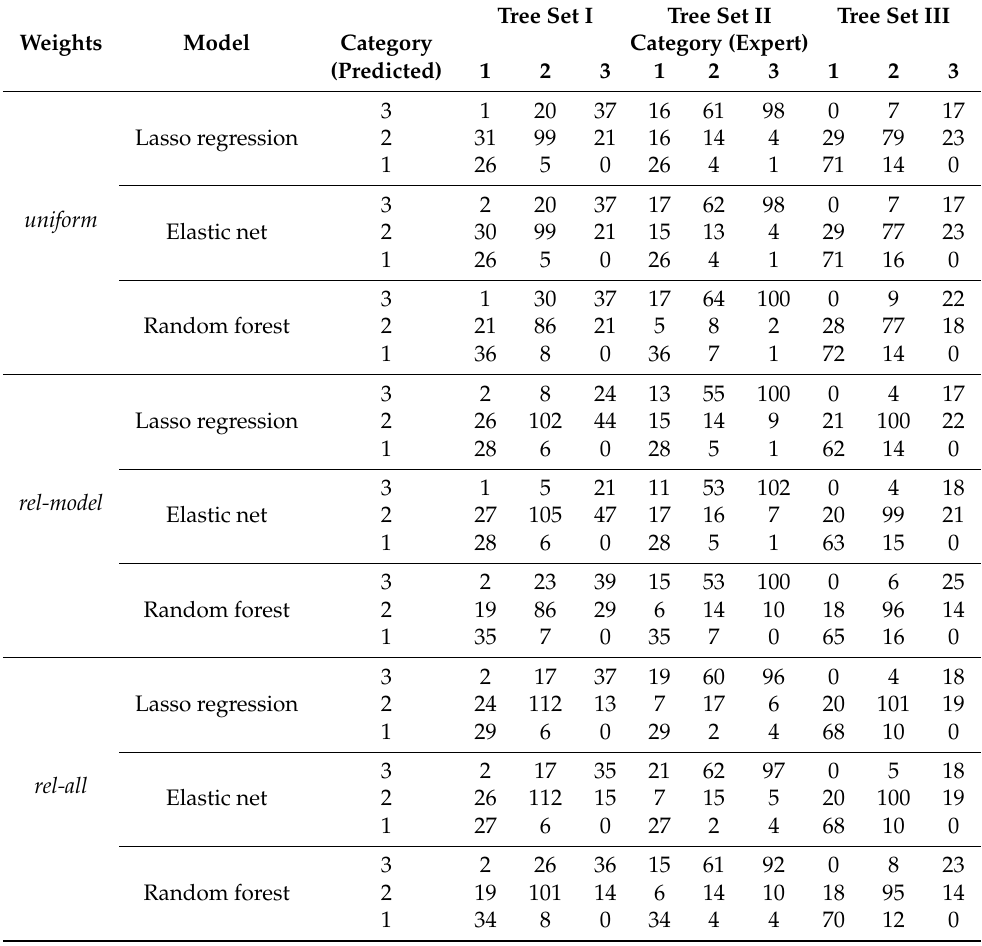
Table A1. Confusion matrices (absolute numbers) for all tree sets and weights. For each weight, the data are organized as in Figure 8. Category numbers correspond to the respective categories of each tree